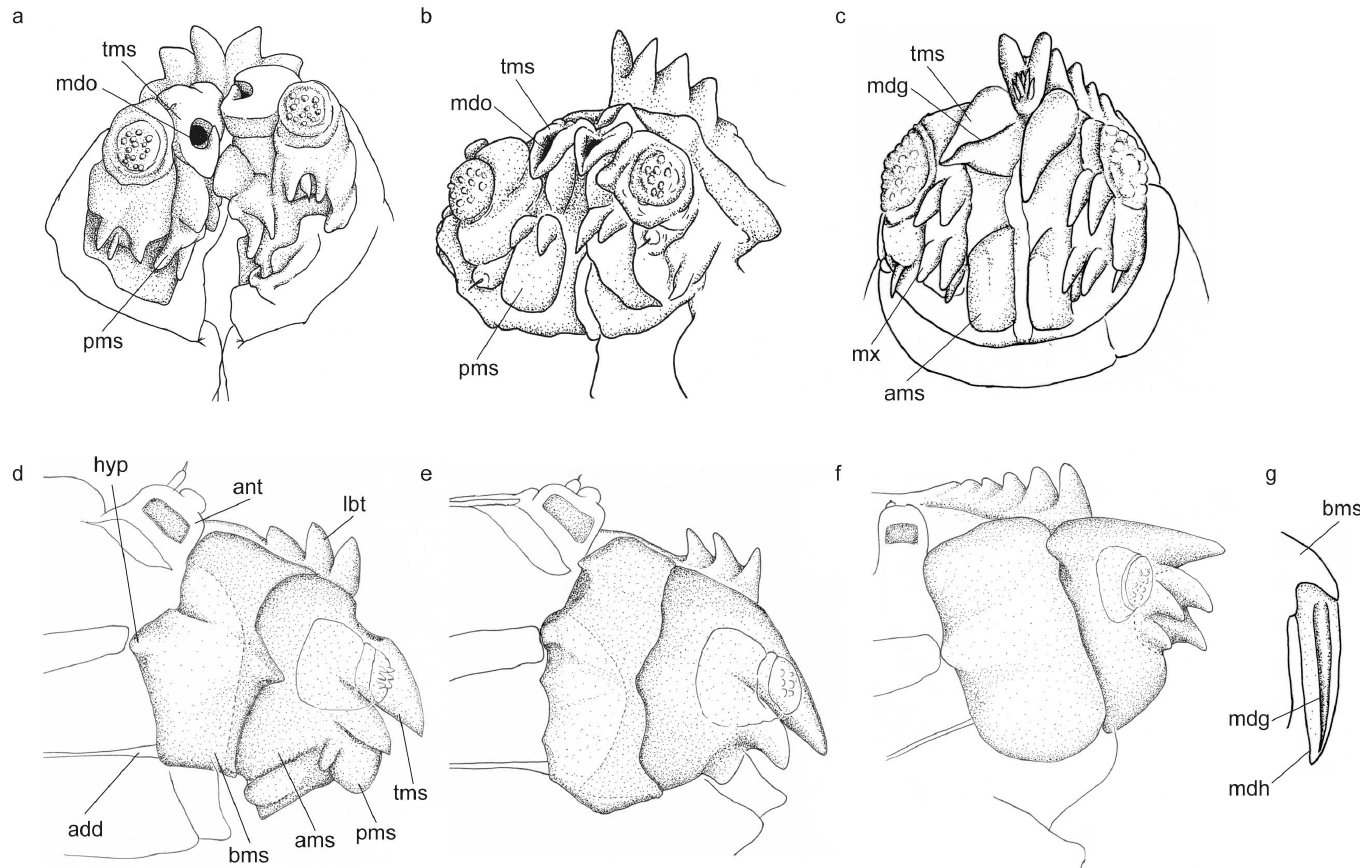
Fig 3. Cephalic features of final instar larvae of bryophyte-feeding rhagionids. Cephalicfeatures illustrated based on SEM view, ventro-frontal view (a- c): (a) Spania sp.; (b) Litoleptis japonica ;(c) Ptiolina sp. Cephalicskeleton features illustrated based on the dissected specimens, aboral view (d-f): (d) Spania sp.; (e) Litoleptisjaponica ;(f) Ptiolina sp. (g) mandibularhook of Symphoromyia sp., illustrated based on [17]. Abbreviations : add = adductor apodeme; ant = antenna; ams = apical mandibularsclerite; bms = basal mandibularsclerite; hyp = hypocondyle; lbt = labral teeth; mdg = mandibular groove; mdo = mandibular orifice; mdh = mandibularhook; mx = maxilla; pms = lower projections of apical mandibularsclerite; tms = upper tooth of apical mandibularsclerite